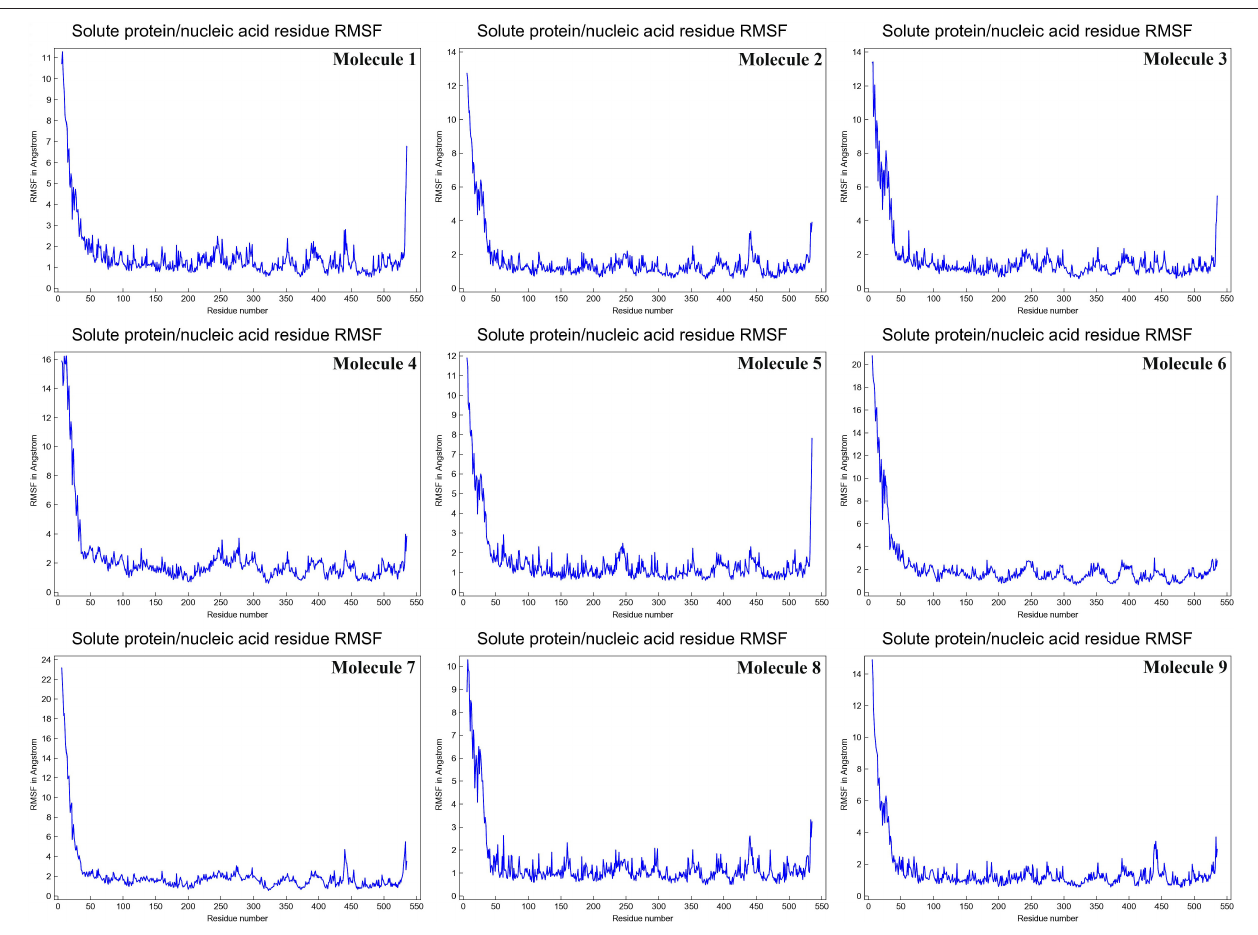
FIGURE 5 | Calculations of the root mean square fluctuation per solute protein acid residue from the average RMSF of the atoms constituting the residue of CYP51 and nine molecules as a function of 10 ns simulation